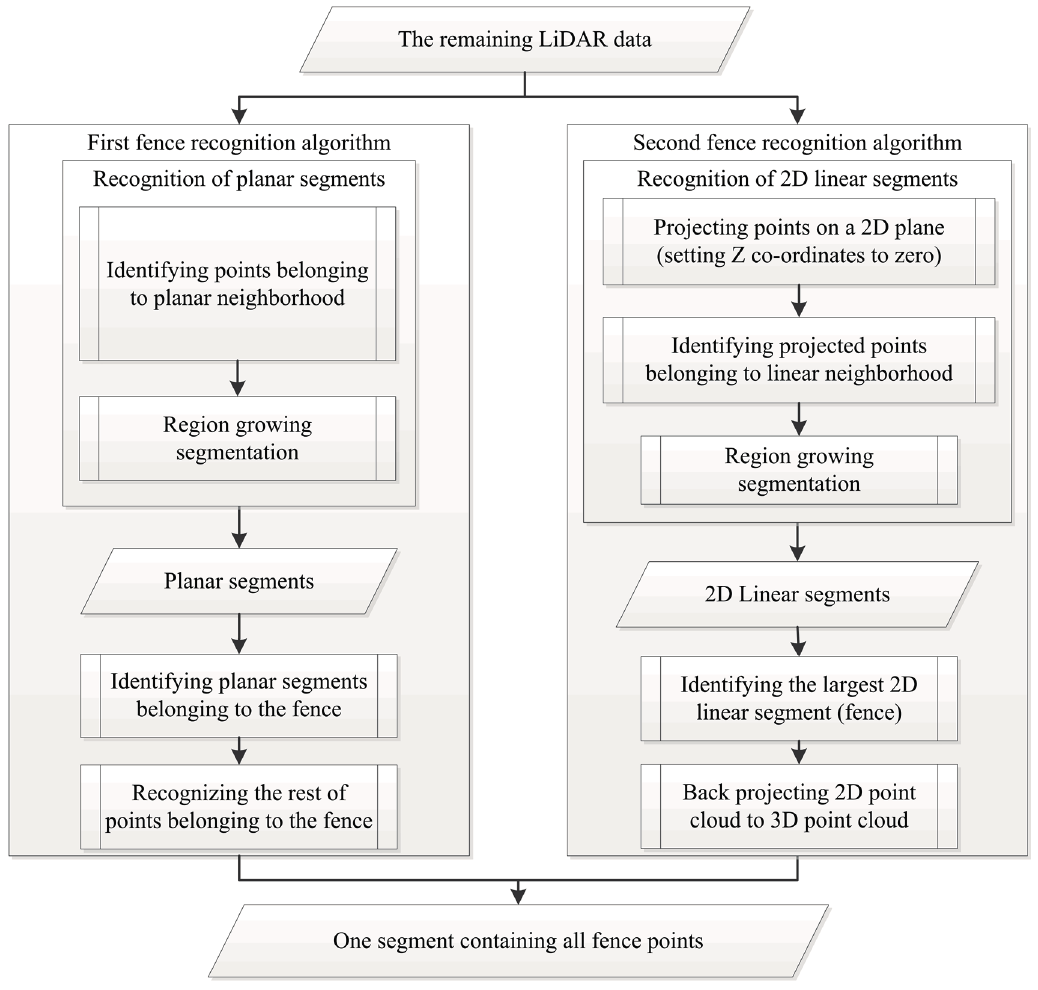
Figure 4. Flowchart of two developed algorithms for fence